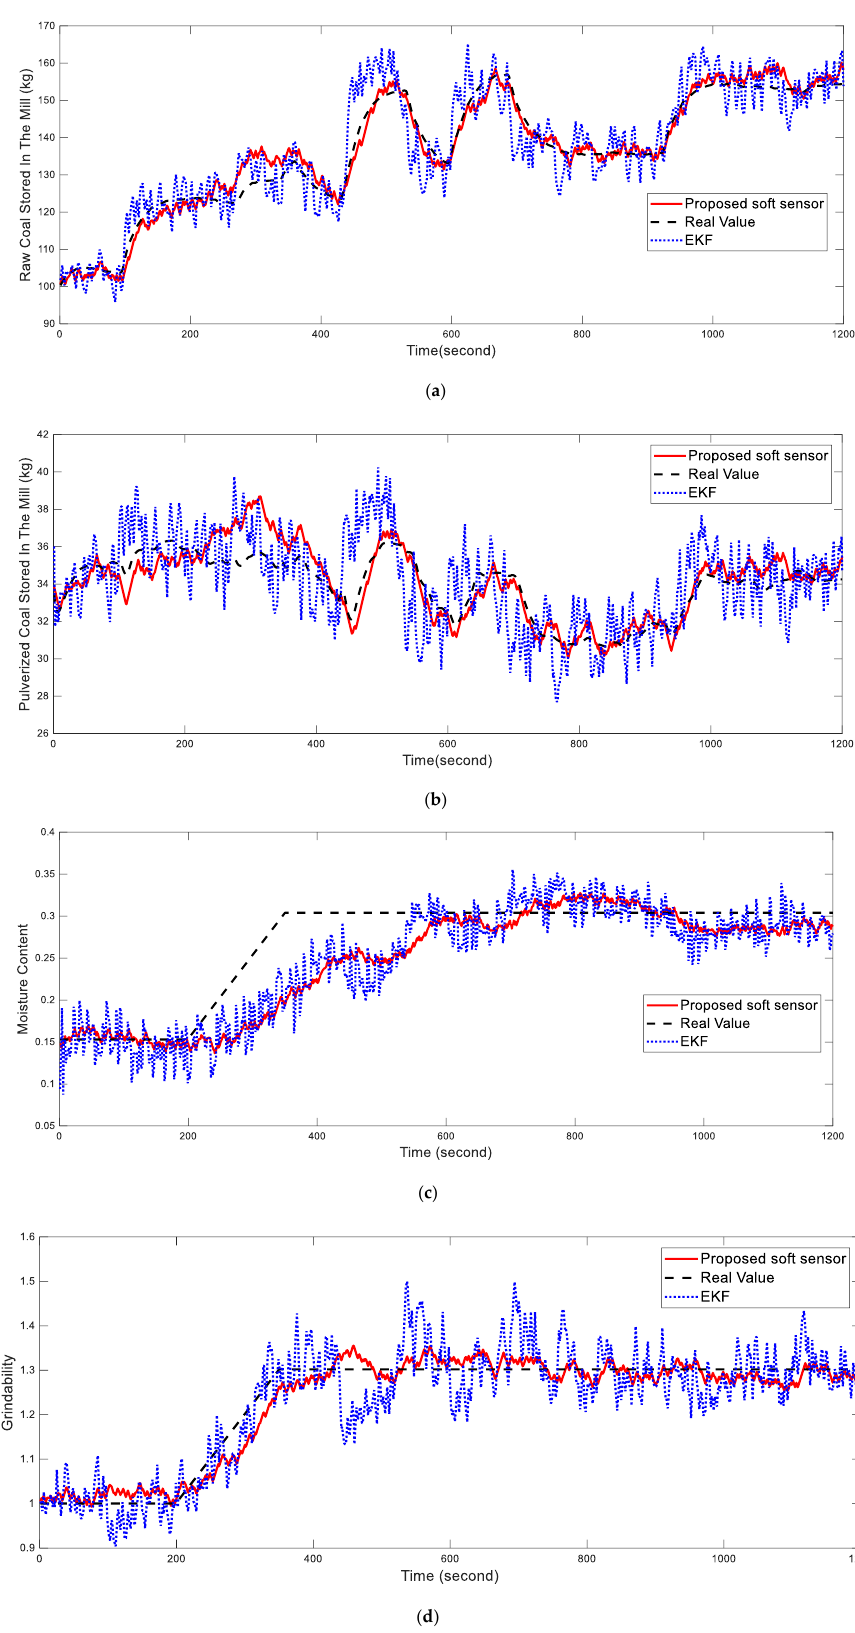
Figure 9. Estimates of ( a , b ) unmeasurable states and ( c , d ) raw coal parameters. ( a ) Raw coal stored in the mill; ( b ) Pulverized coal stored in the mill; ( c ) Moisture content; ( d ) Grindability.